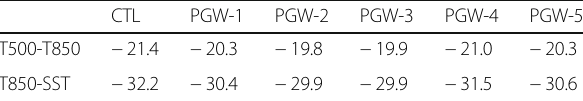
Table 6 Difference of atmospheric temperature at 500 hPa and 850 hPa (T500-T850), and difference of atmospheric temperature at 850 hPa and sea surface temperature (T850-SST)